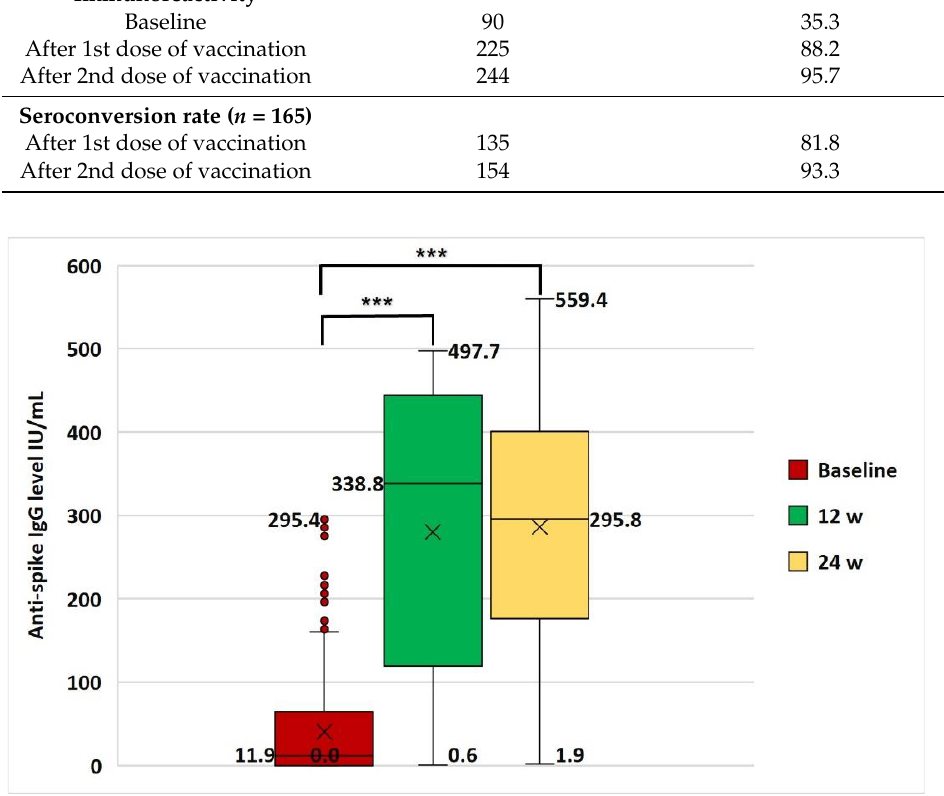
Figure 4. Anti-spike IgG antibody serum level (median and range) at baseline, 12 w, and 24 w time points of the study. Data were analyzed by Wilcoxon Signed Ranks Test and significant difference was defined as *** p < 0.001. w, week; ×, mean.